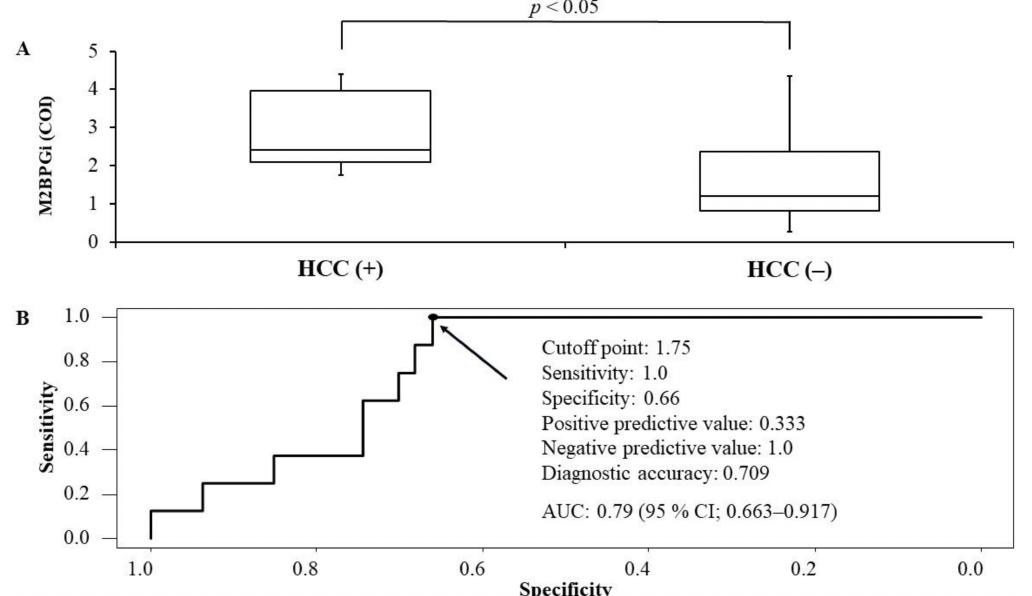
Figure 4. The comparison between mac-2 binding protein glycosylation isomer (M2BPGi) levels between patients who developed hepatocellular carcinoma (HCC) or not ( A ) and receiver operating characteristics analysis regarding the cutoff of M2BPGi levels for the development of HCC ( B ) after the start of daclatasvir + asunaprevir among the cases without HCC history. According to the Youden index, the best cutoff of M2BPGI levels was 1.75 (sensitivity: 1.0, specificity: 0.66, positive predictive value: 0.333, negative predictive value: 1.0, diagnostic accuracy: 0.709). Area under the curve was 0.79 (95% confidence interval: 0.663–0.917).